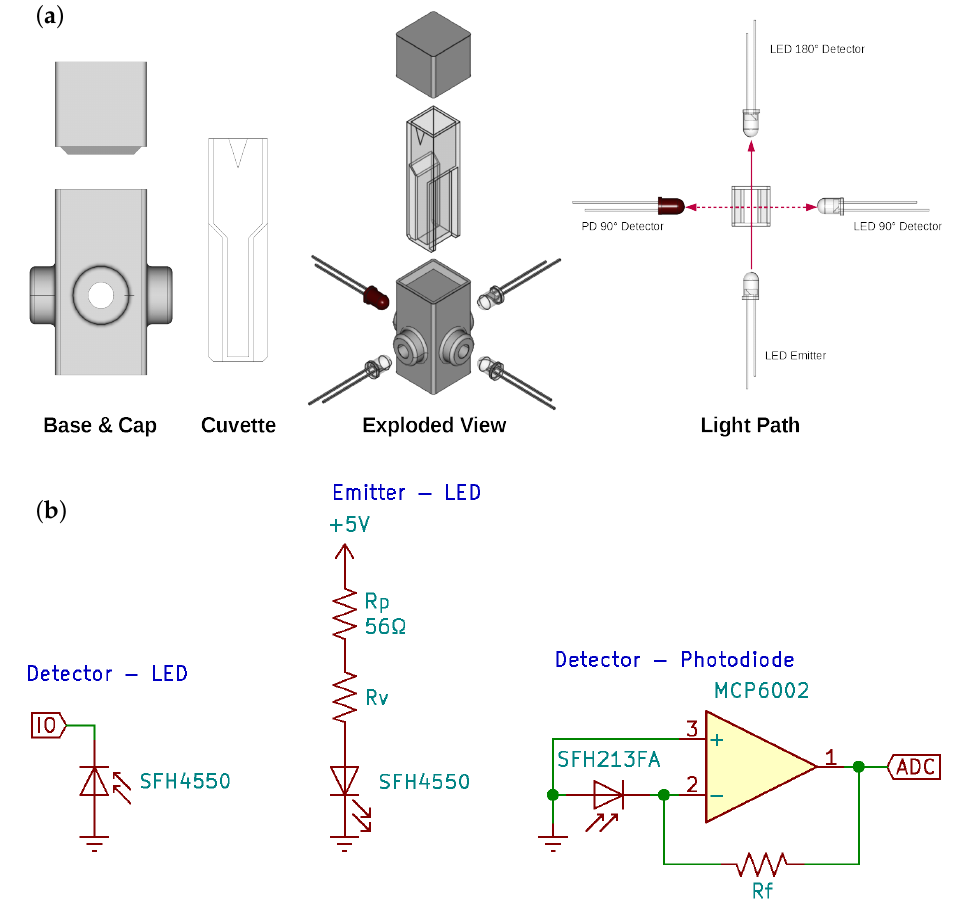
Figure 1. Chamber and electrical CAD design of the detection system. ( a ) Chamber CAD design and all possible light arrangements for the detector photodiode (PD) and light emitting diode (LED). ( b ) Electrical schematic showing the components and implementation required for the detector LED ( left ), emitter LED ( middle ) and detector photodiode ( right ). R p : Protective resistor. R v : Variable resistor. R f : Feedback